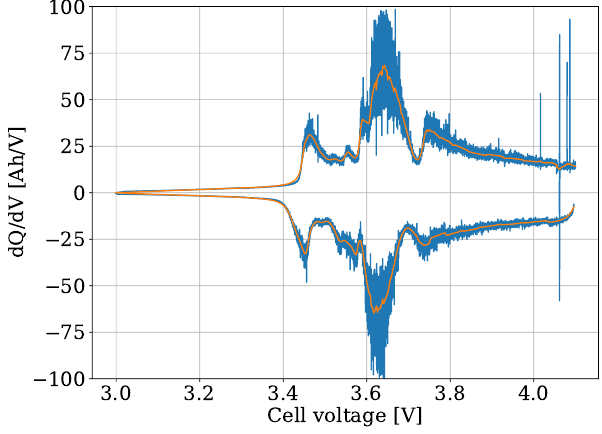
Figure 4. ICA test carried out at 28 Ah NMC LIB cell at BOL.